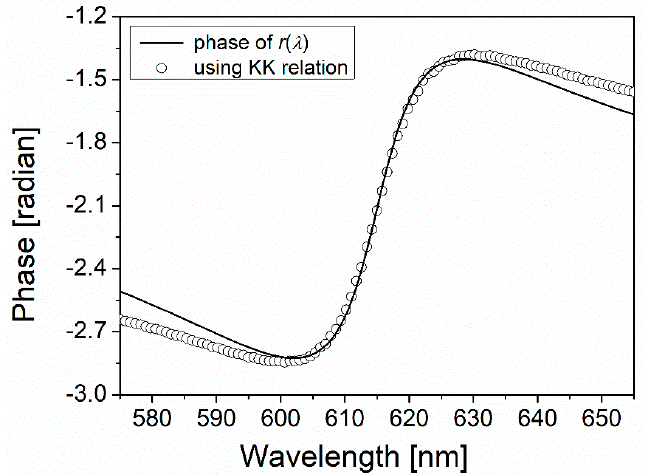
Figure 4. The wavelength-dependent phase calculated using the KK relation in comparison to the phase of r ( λ ) calculated from a field transfer matrix formula (Equation (1)). The incident angle ( θ in ) is 43.85°.